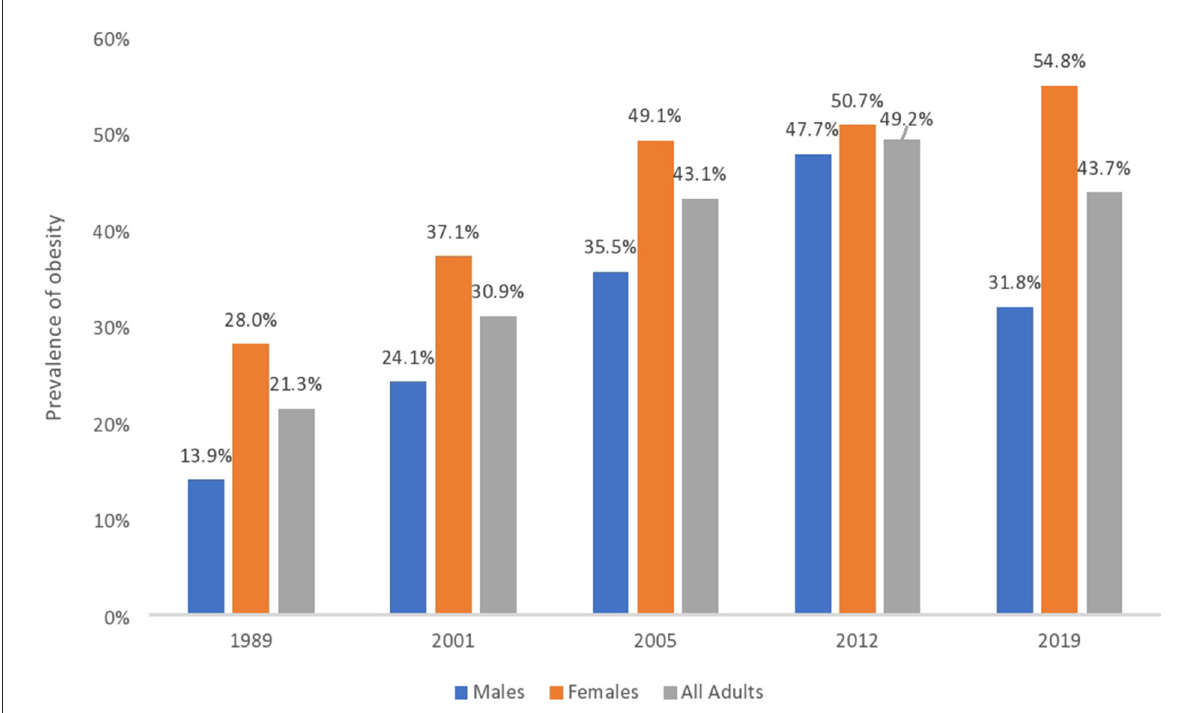
FIGURE1 The prevalence of obesity in The Bahamas disaggregated by sex and year. Bahamian national reports show a consistent increase in the prevalence of obesity in adults between 1989 and 2012. It also shows a decrease in adult prevalence rates between 2012 and 2019. There is, however, a gendered health disparity. Prevalence rates continue to increase in women up to 2019 but have decreased in men between 2012 and 2019. The years listed represent the times when data were available from reports of Bahamian national